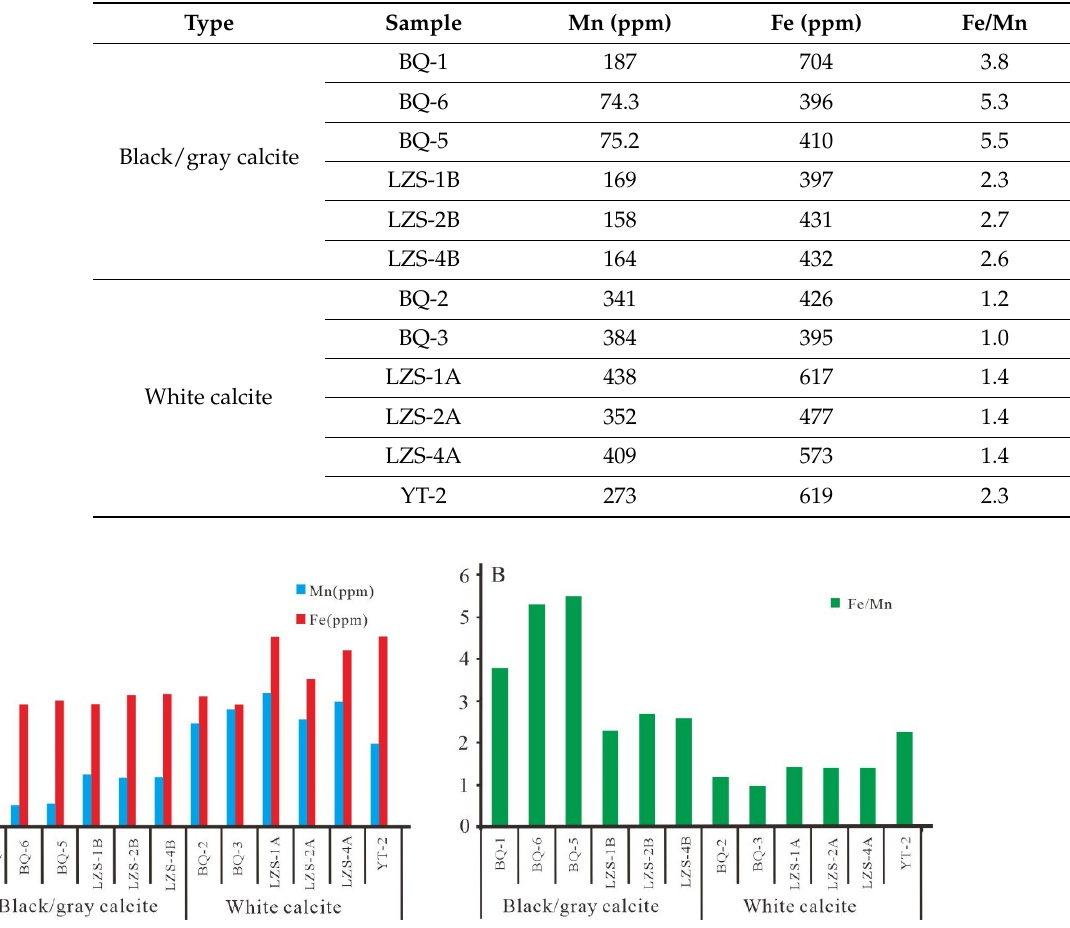
Table 2. Fe and Mn content of calcite in the Banqi-Yata-Laiizishan area.